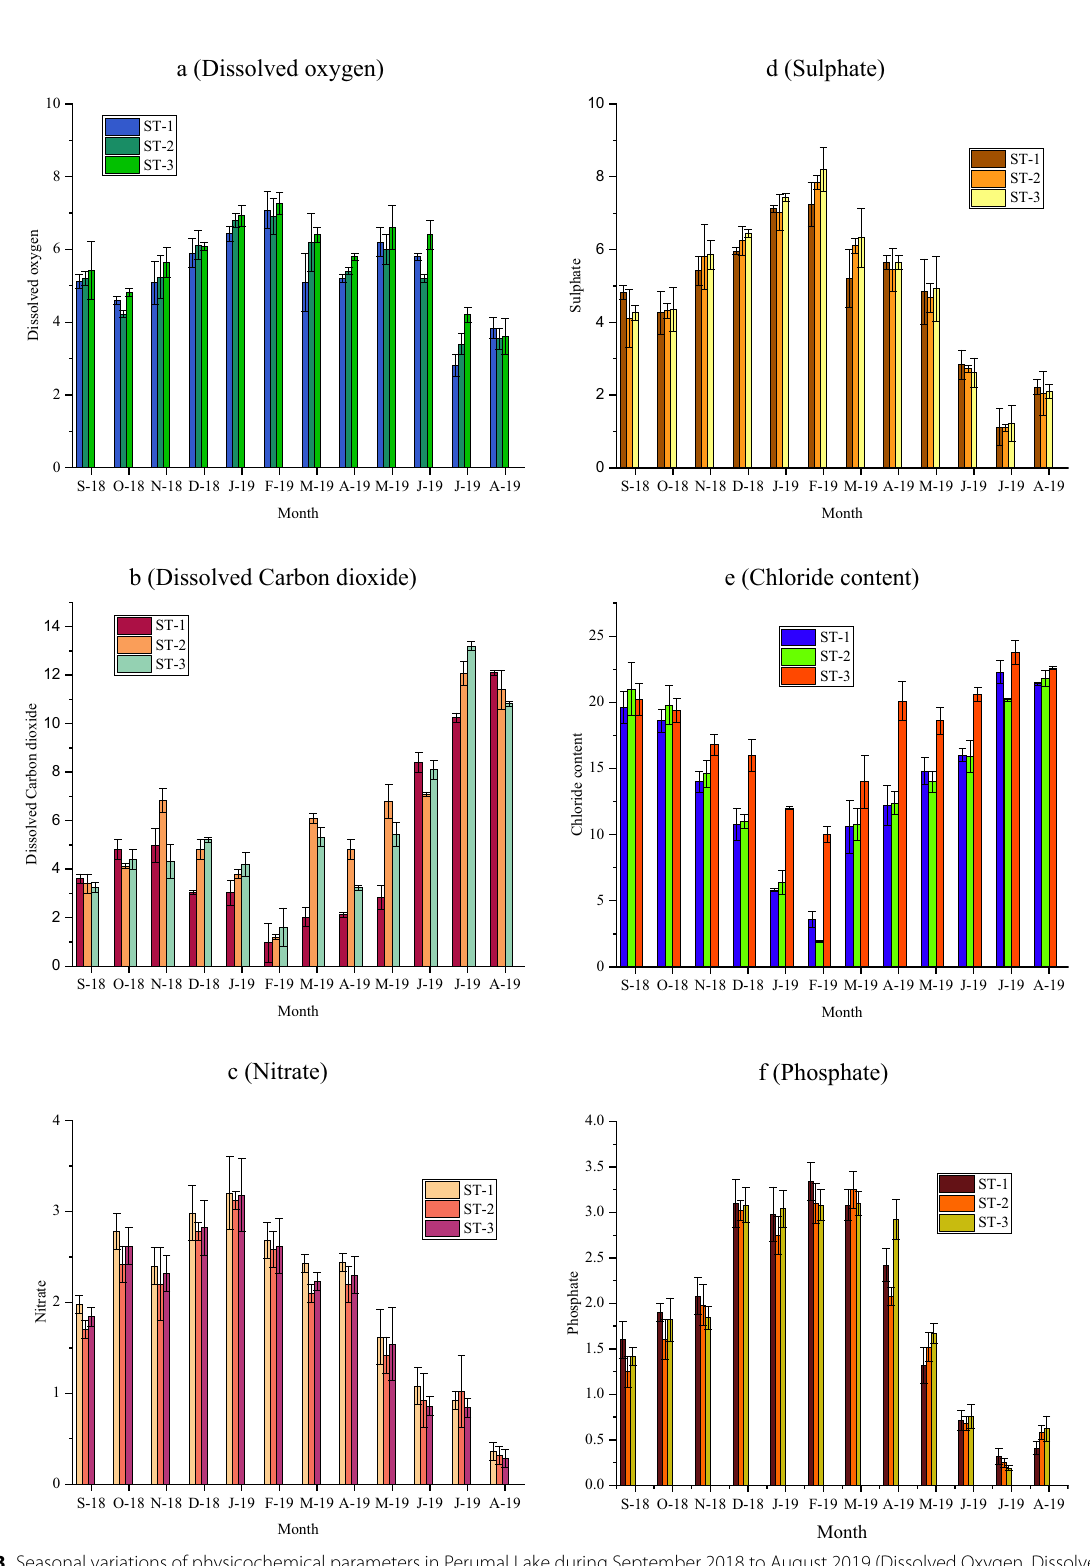
Fig. 3 Seasonal variations of physicochemical parameters in Perumal Lake during September 2018 to August 2019 (Dissolved Oxygen, Dissolved Carbon dioxide, Nitrate, Sulphate, Chloride content and